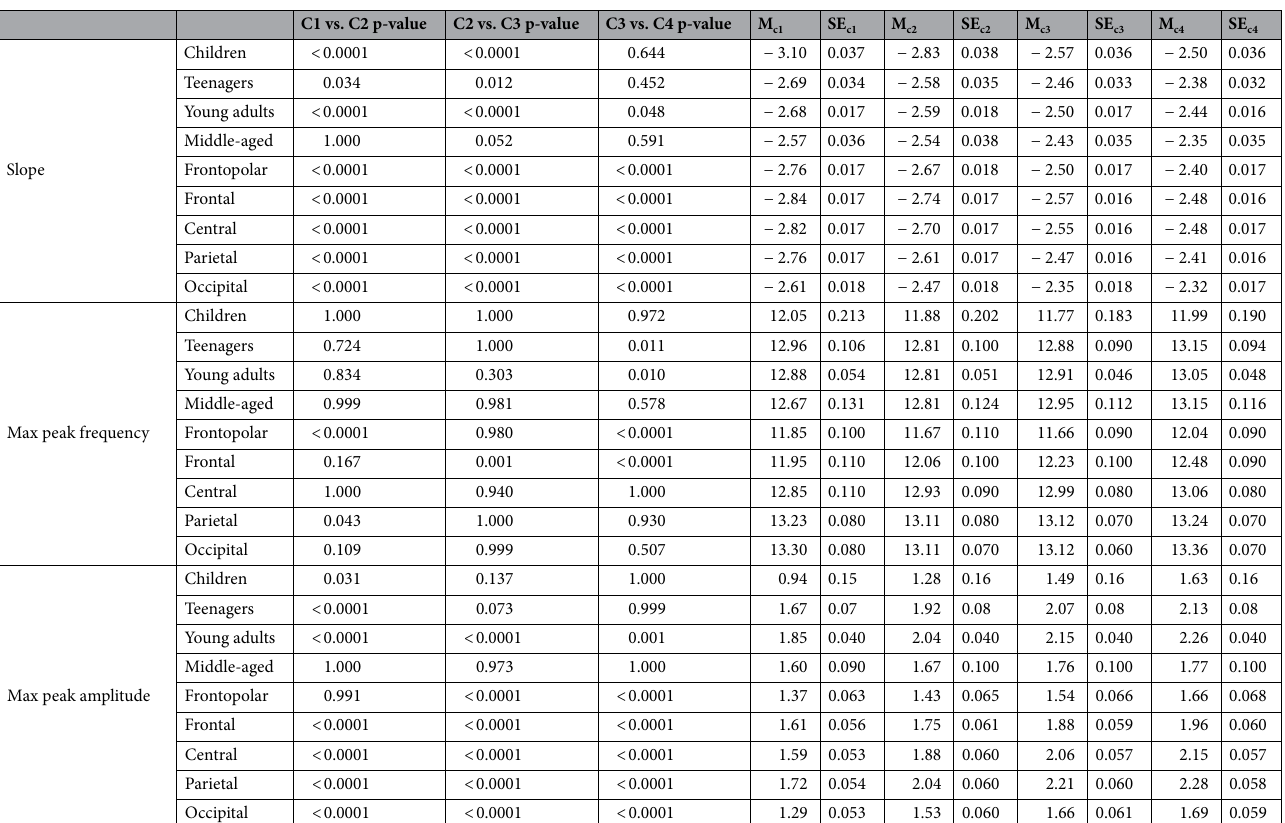
Table 2. Descriptive statistics and post-hoc test (unequal N HSD) results on the cycle dynamics of the 3 spectral parameters. The table displays the difference between sleep cycles (C1, C2, C3, C4) in particular age groups and regions. M, mean; SE, standard